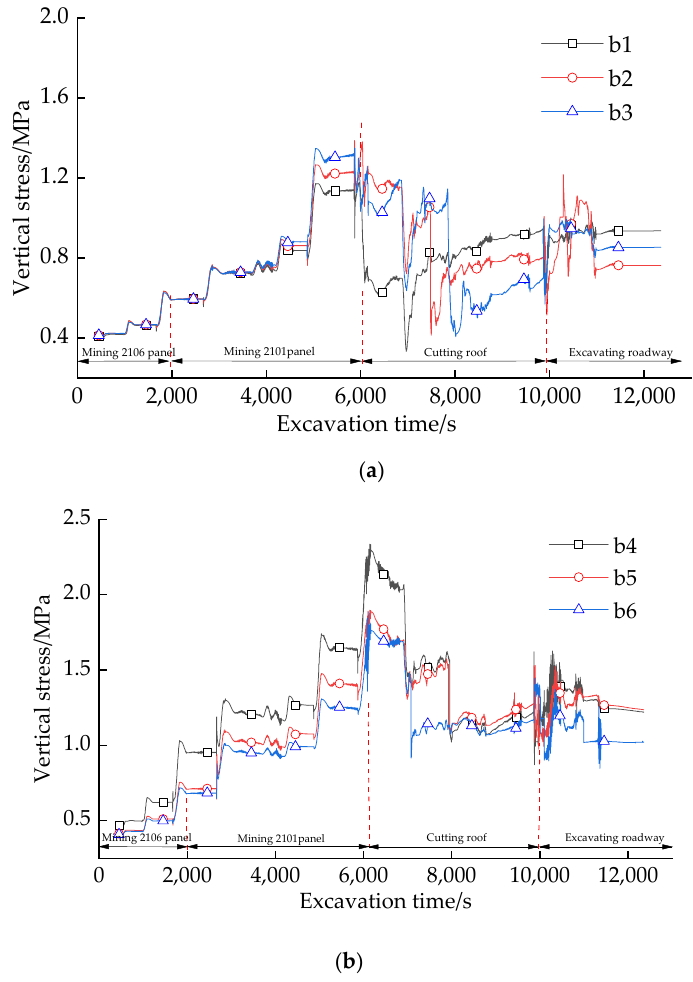
Figure 9. The vertical stress evolution of the two ribs of the gob-side entry. ( a ) Panel rib near the 2106 lower panel; ( b ) coal-pillar rib near the 2101 gob.